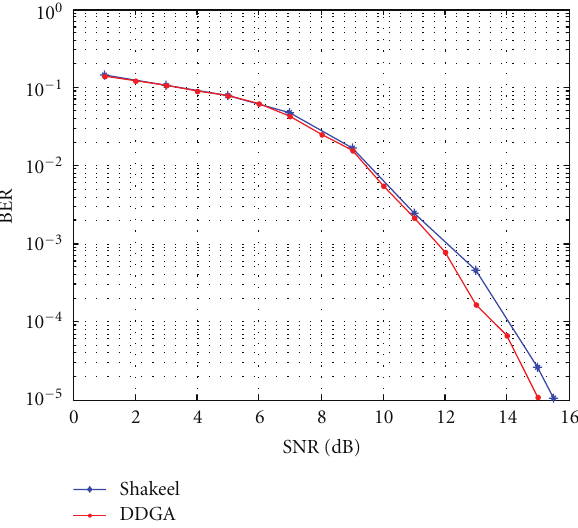
Figure 25: Performances of DDGA, and Shakeel algorithms for BCH (127,113,5) code on